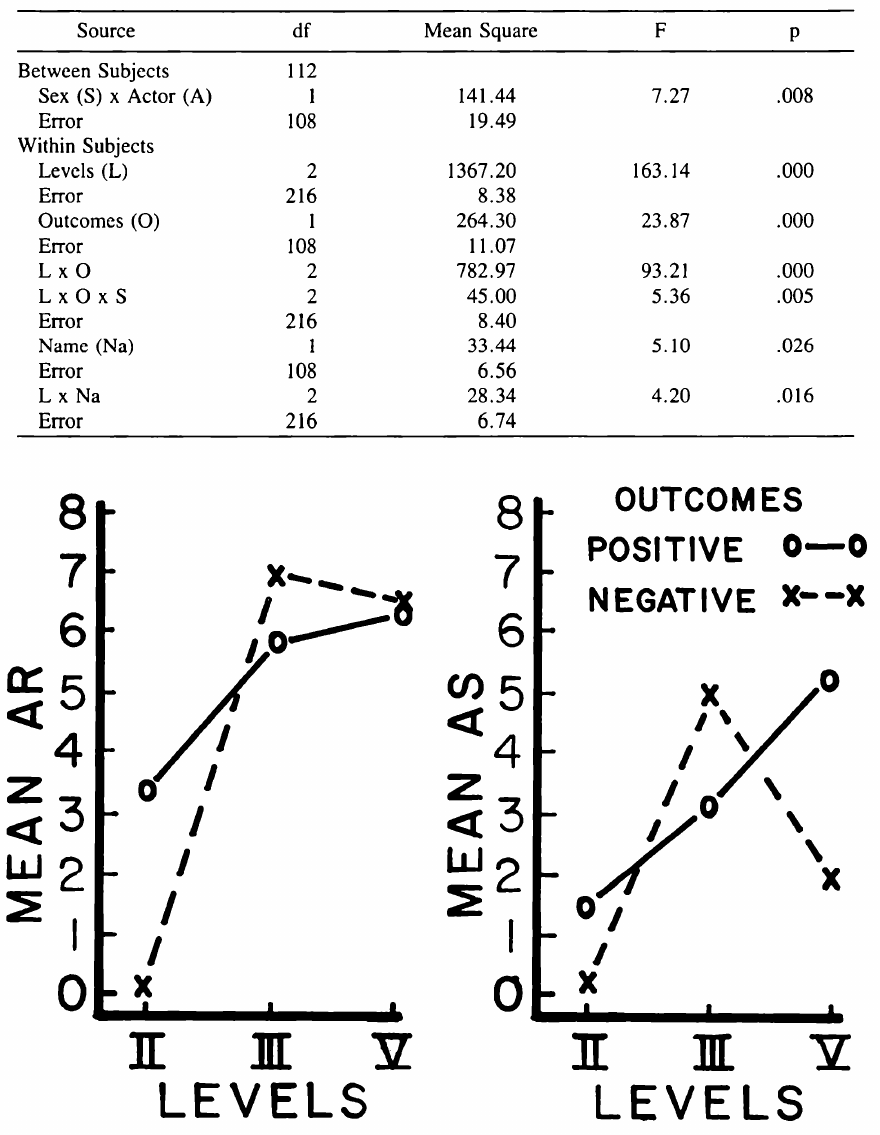
Figure I.A. Mean attribution of responsibility ratings (AR) for positive and negative outcomes at each of Heider's three levels. Figure 1.B. Mean assignment of sanctions ratings (AS) for positive and negative outcomes at three of Heider's levels. (The key in Figure LB. applies to both